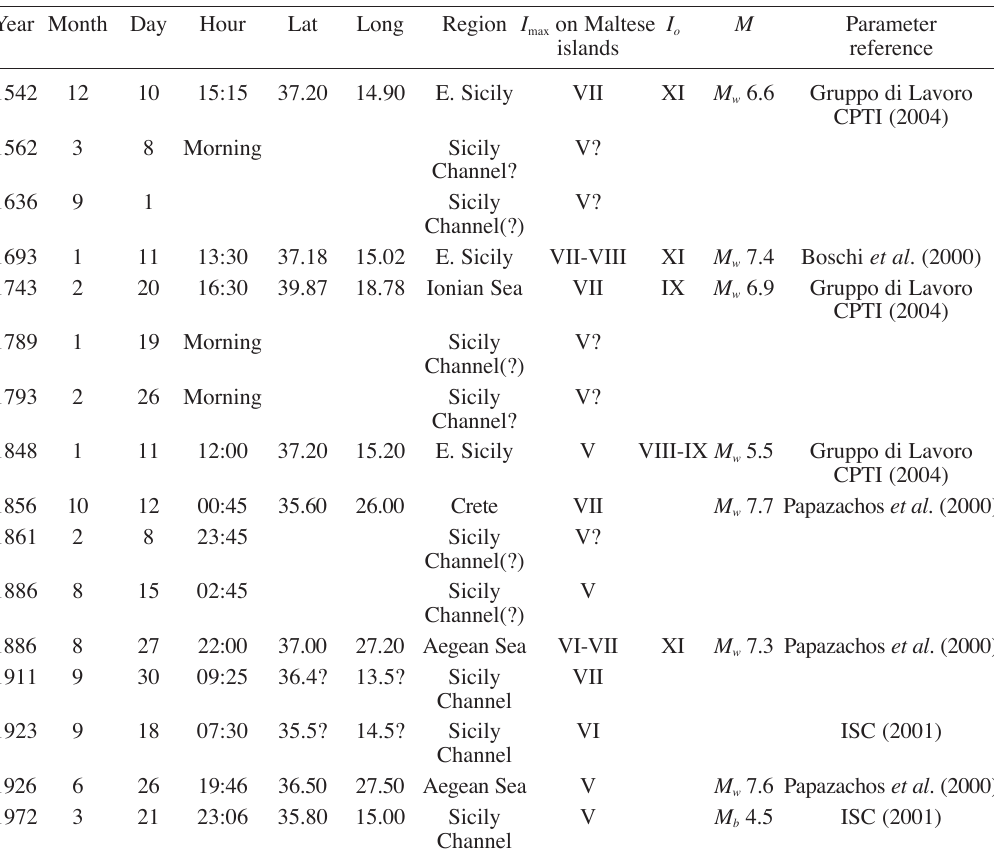
Table I. Subset of felt earthquake catalogue, showing only events that produced EMS-98 I = V and over on the Maltese islands. Year Month